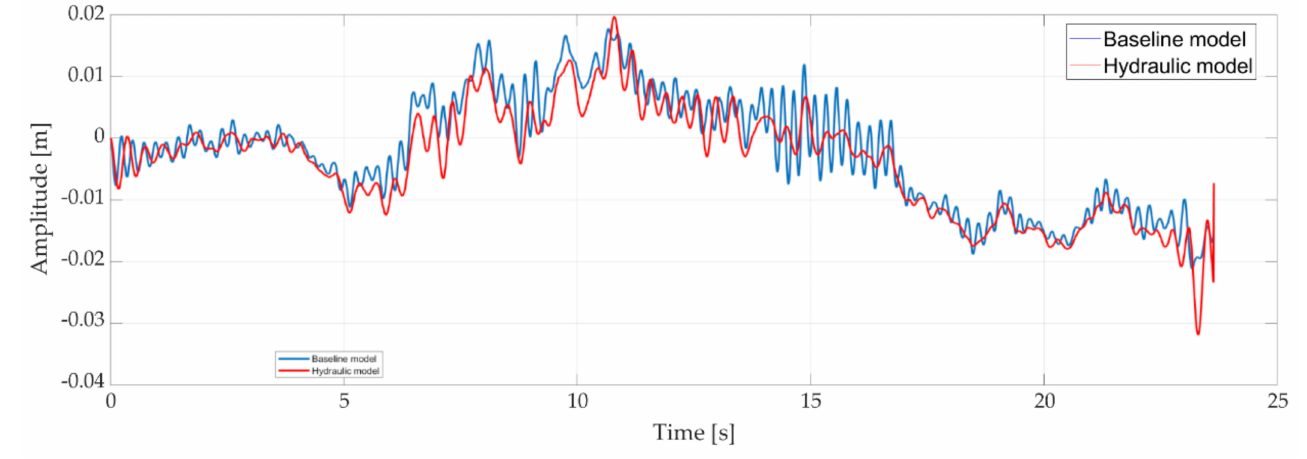
Figure 22. The bounce response to a realistic road profile and external accelerations.